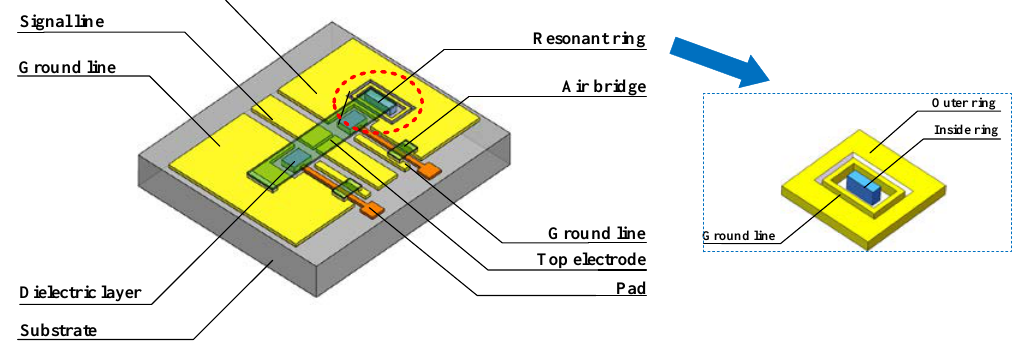
Figure 1. Structure of the RF MEMS filter. ( a ) MEMS filter; ( b ) resonant ring.